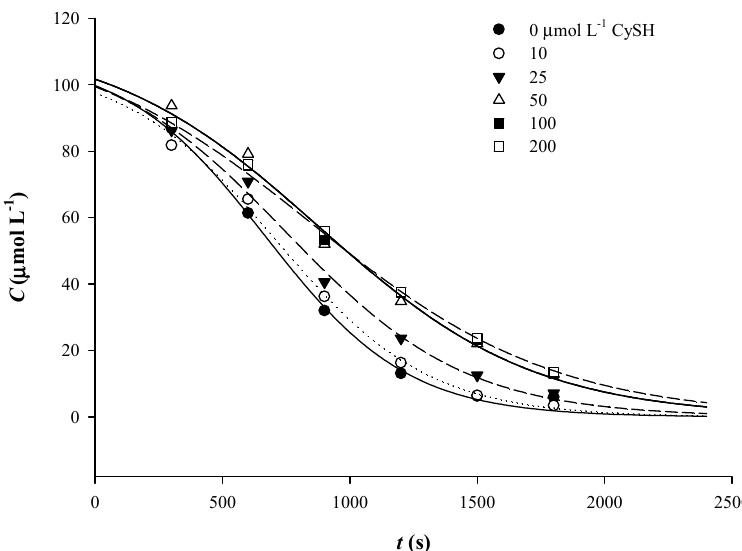
Figure 6. Implementation of the sigmoidal kinetic model to trace Qt thermal degradation in the presence of various concentrations of CySH.